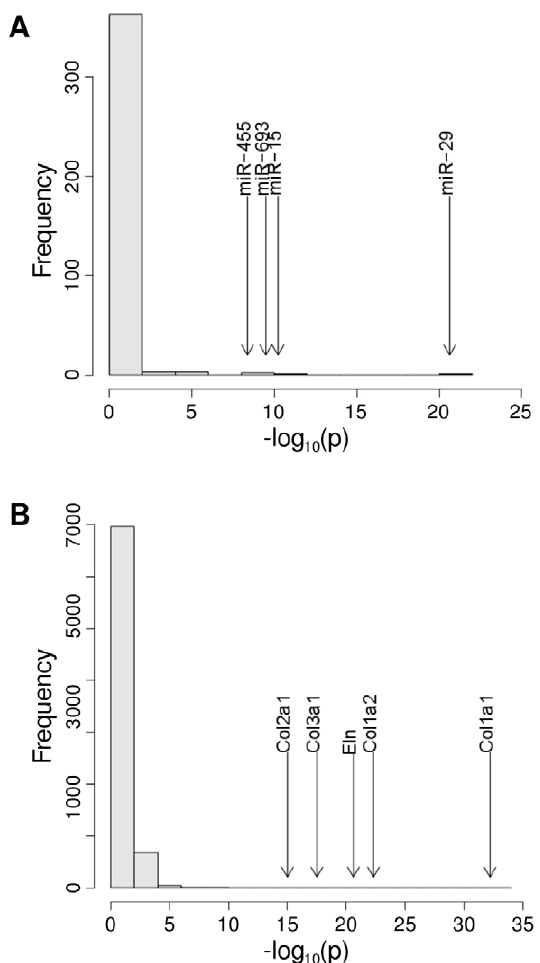
Figure 6. miR-29 is overrepresented in Eln and multiple collagen genes. A When compared to the expectation under a random sequence model, Eln mRNA possesses a highly significant excess of miR-29 and miR-15 MREs. The number of MREs for each of 373 miRNA families in the entire elastin mRNA sequence was counted and compared to the expectation under a random sequence model based on the Poisson distribution. Results are displayed as a histogram of the negative decadic logarithm (for instance, the p -value for miR-29 of p ~ 2 : 365 | 10 { 21 is displayed as { log 10 ( p ) ~ 20 : 630 ). Arrows indicate the position of the four most highly significant miRNAs. B The number of MREs for miR-29 was counted in the mRNA sequences of each of 33,394 murine genes, using only the longest transcript for genes with alternative transcripts. The counts of miR-29 MREs were compared to a random sequence model. Results for the 7,675 genes with at least one MRE for miR-29 are displayed as a histogram of the negative decadic logarithm. Most mRNAs did not show significant enrichment. In addition to Eln , a number of collagen genes showed highly significant enrichment. See also Supplementary Table S5 for counts of miR-15 and miR-29 family MREs.